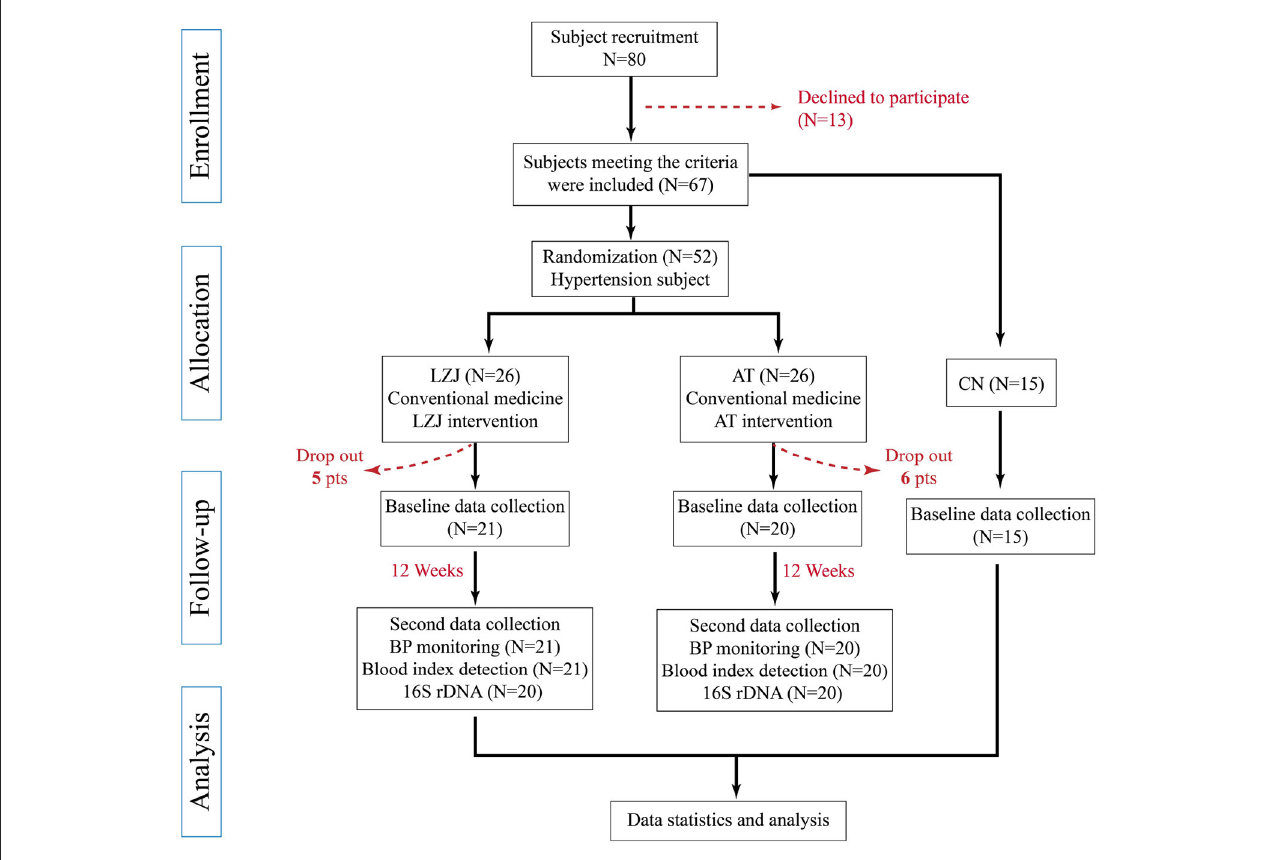
FIGURE1 Flow diagram of the study from recruitment to the end of the intervention.